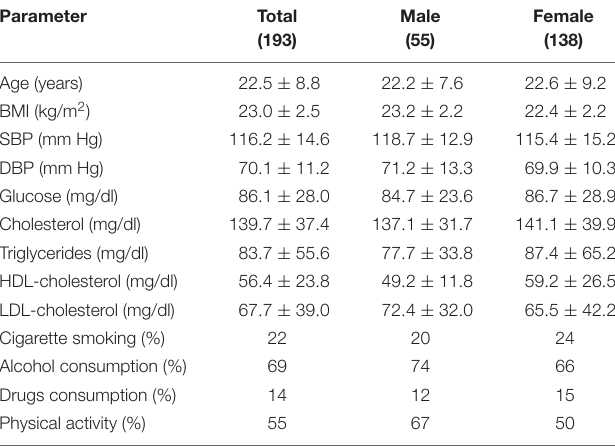
TABLE 1 | Anthropometric features and clinical parameters of the studied individuals.